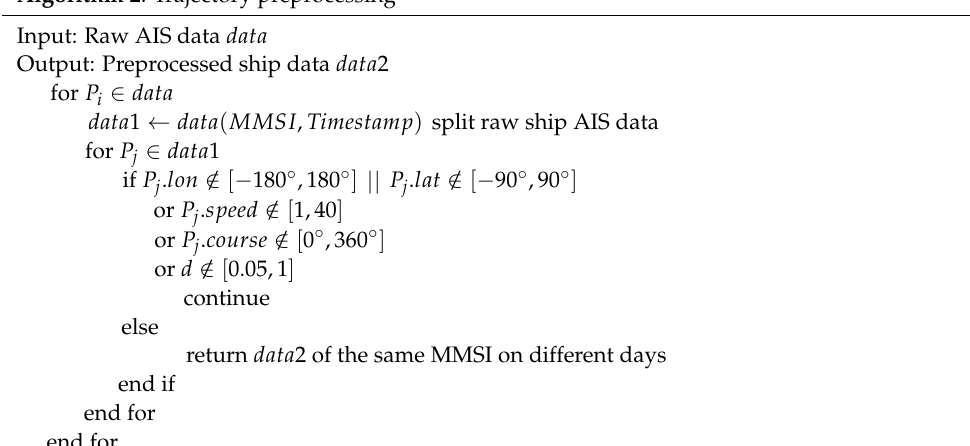
Algorithm 2 : Trajectory